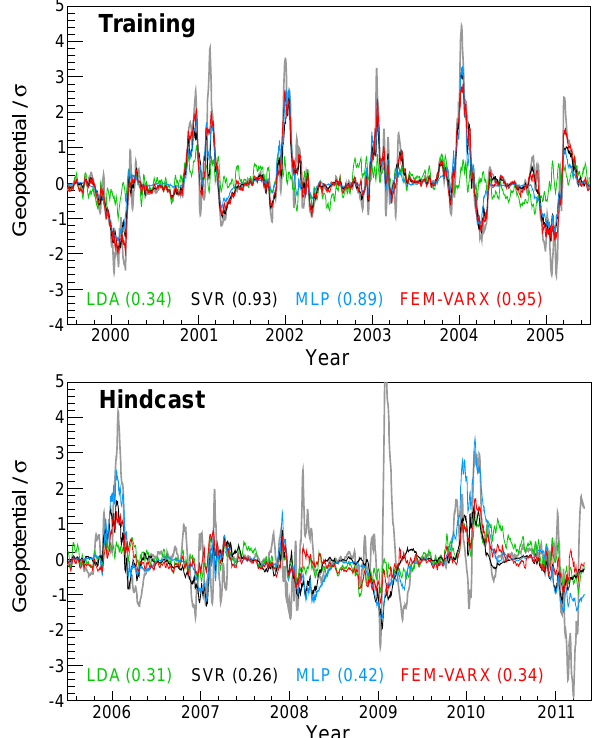
Fig. 2. Geopotential results for the training period (top) and the hindcast period (bottom) for each of the statistical models together with the correlation coefficient R (in parentheses) calculated be- tween the particular model and truth (gray). The hindcast is shown for the full hindcast period whereas the training results are only shown for a representative period (last six years). Labeled year is the first of January of the particular year. The 95% confidence in- terval of the correlation factors are ± 0 . 02 for the training and ± 0 . 04 for the hindcast